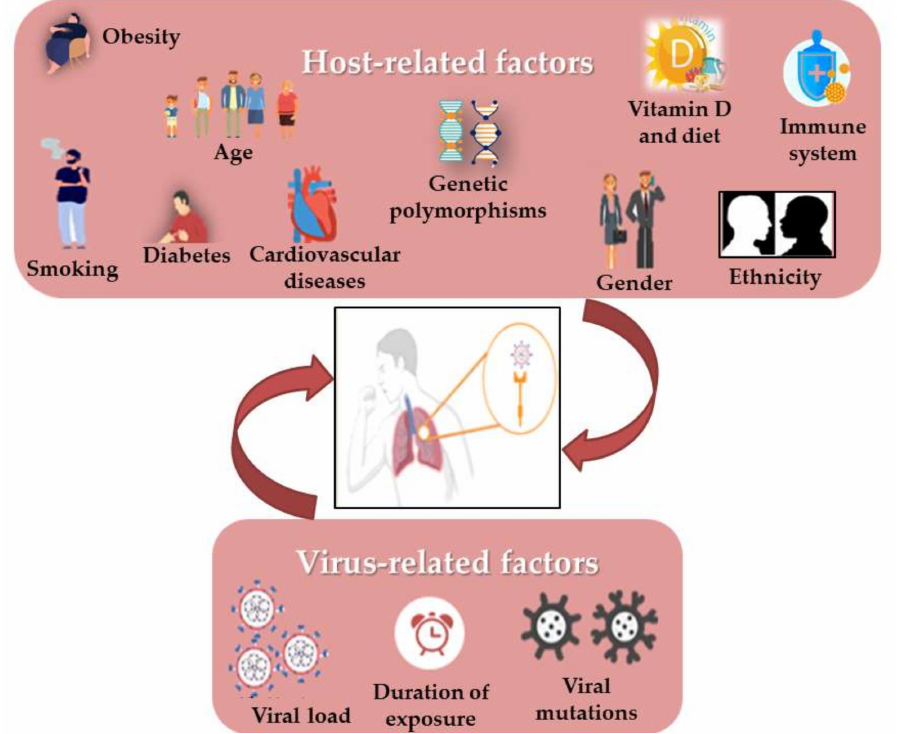
Figure 2. Host and virus-related factors affecting COVID-19 outcome. Several factors related to the virus and to the host could account for COVID-19’s severity among individuals. A strong immune response is essential to eliminate the virus before its progression to more severe stages; therefore, harmful behaviors such as sedentary lifestyle, obesity, elevated tobacco consumption and unhealthy diet may weaken the immune system and render the host more sensitive to the virus. Health status is yet another factor influencing the clinical manifestations of SARS-CoV2 infections. As such, people of older age, especially those with comorbidities such as diabetes and lung and cardiovascular diseases may experience a more severe disease outcome. Moreover, the risk seems to be higher in males than in females, possibly because of the hormonal differences between the two genders as well as their genetic background, especially in the RAS components. RAS overactivity has also been described in metabolic syndrome, type 2 diabetes and obesity, all high-risk conditions for COVID-19 infection and severe disease. On the other hand, a higher viral load of SARS-CoV-2 as well as a sufficient duration of exposure to the virus could be related to more severe illness and even death. More importantly, the viral genetic mutations may favor the appearance of more severe variants, which could have a higher infectivity rate as well as a higher fatality rate among sensitive populations. Feng et al., have shown that a >75 years age group had a higher percentage of patients with critical diseases, comorbidities and death. In fact, the rate of COPD was shown